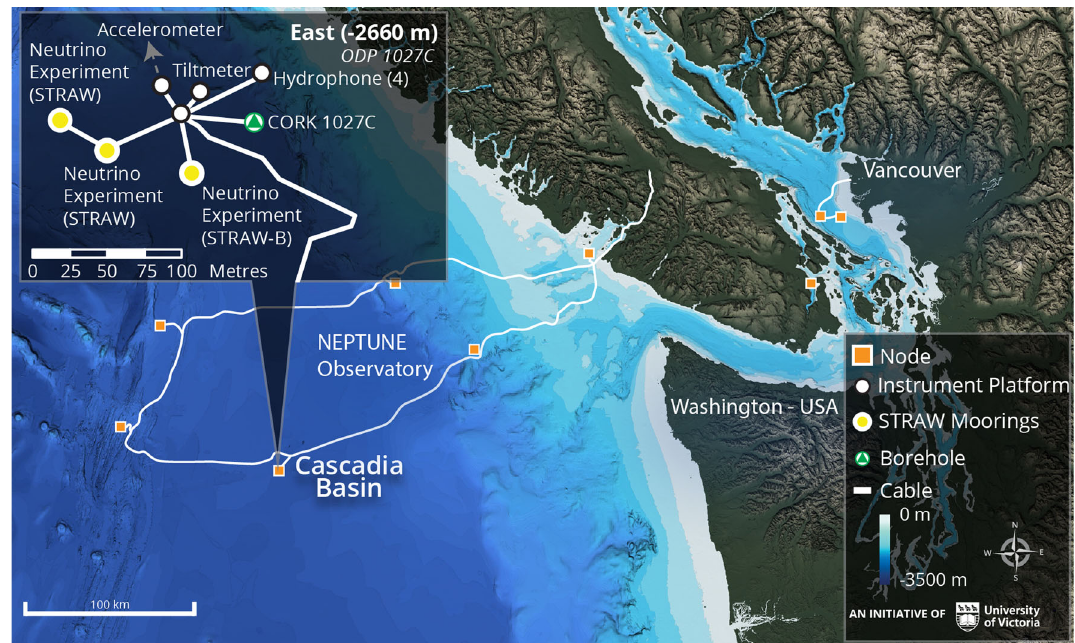
Fig. 1 Map of ONC’s NEPTUNE Observatory. The two STRAW mooring lines are located in the Cascadia Basin at a depth of 2660m. The map also shows STRAW-b, the successor to STRAW, which is currently taking data to complement the results reported here